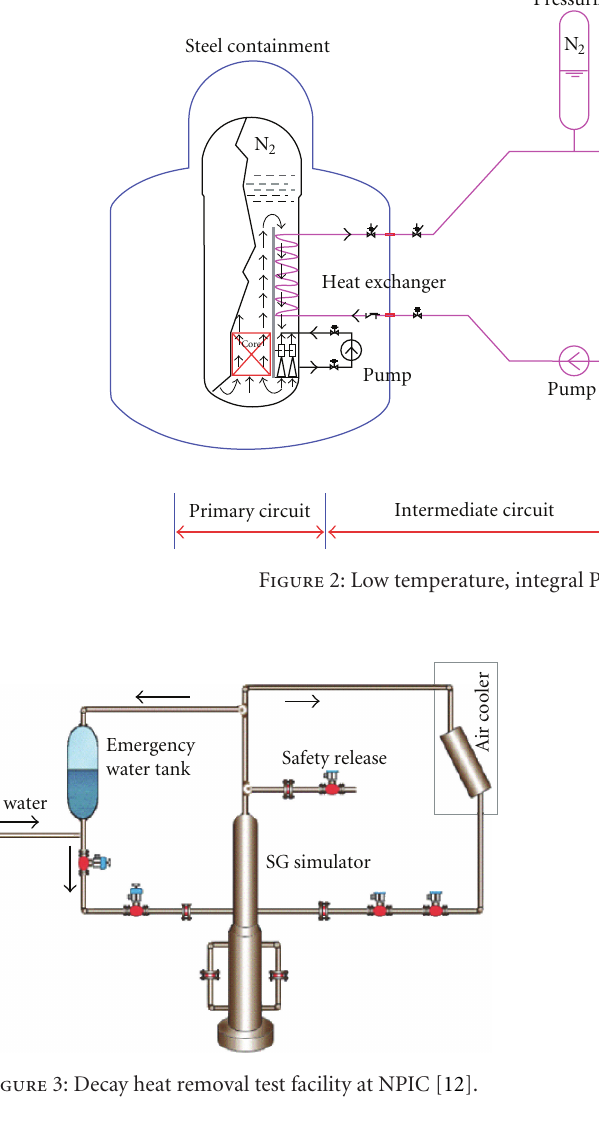
Figure 4: Test facility